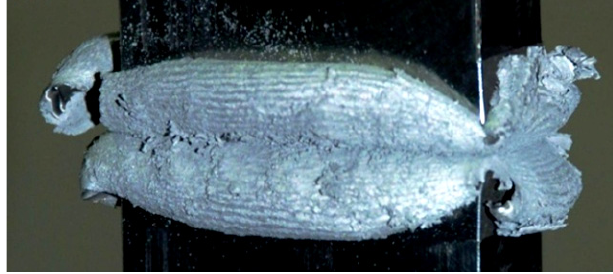
Figura 8: Aspetto del giunto ottenuto per LFW su